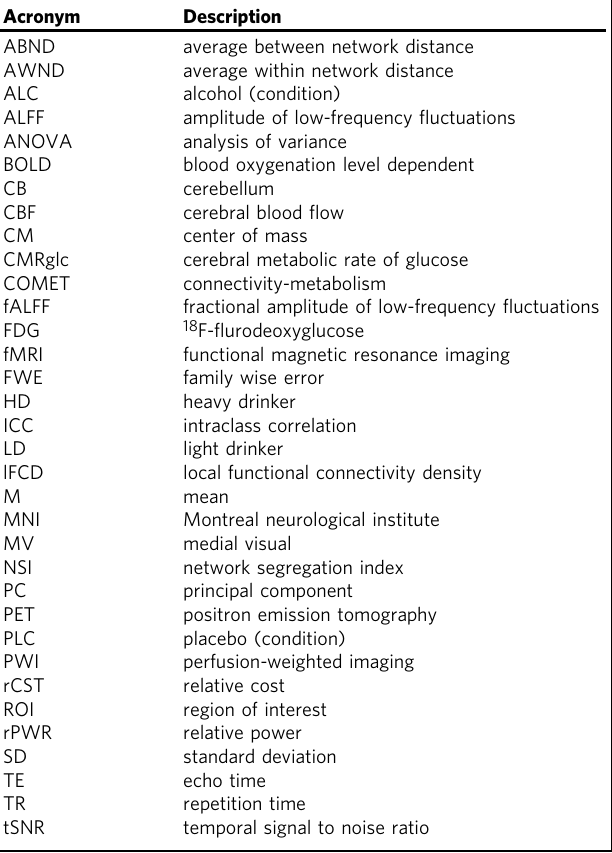
Table 1 List of acronyms used in the text and